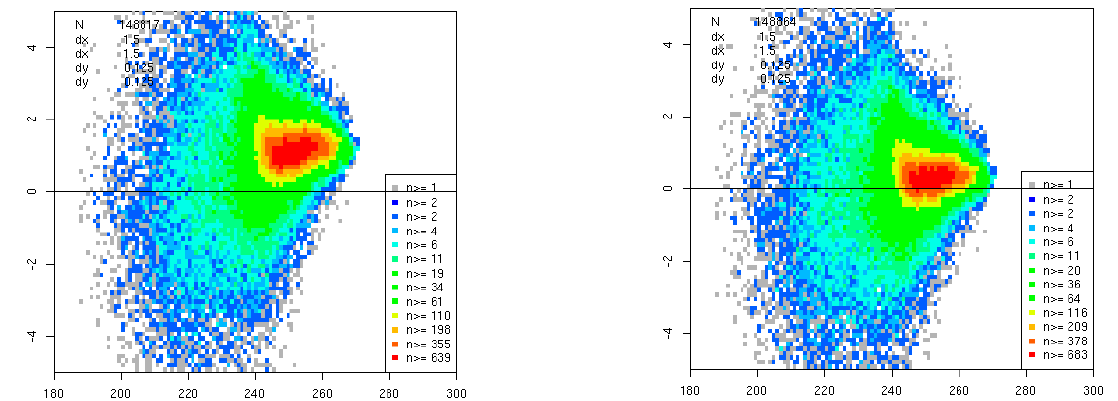
Figure 14. The di ff erence between observed GMS-5 / VISSR brightness temperature and pseudo